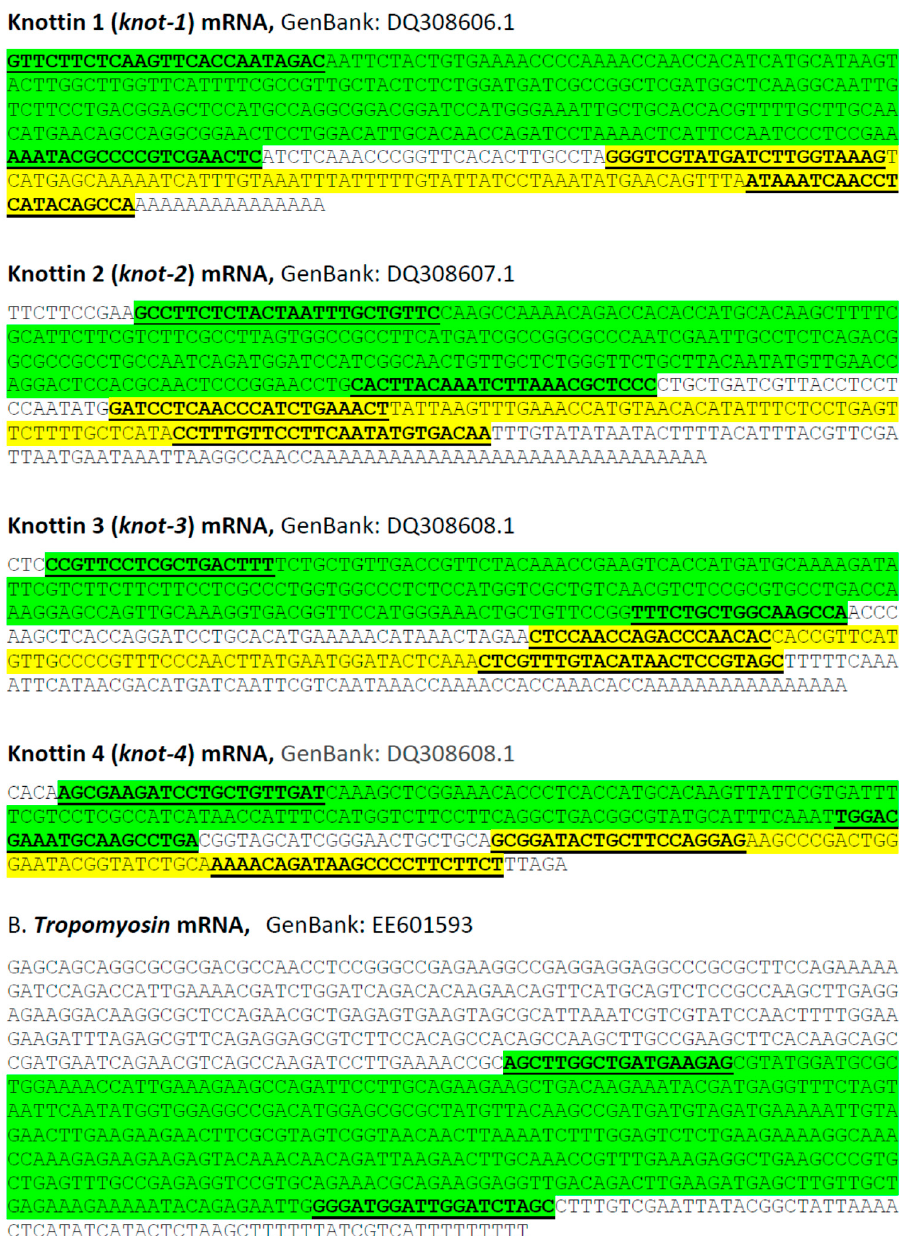
Figure 1. Sequences of whitefly knottin genes. Sequences retrieved from GenBank. The whitefly tropomyosin gene served as control for gene silencing. The primers used to amplify the gene fragment used for dsRNA synthesis (green) and for measuring expressing by qPCR (yellow) are underlined.